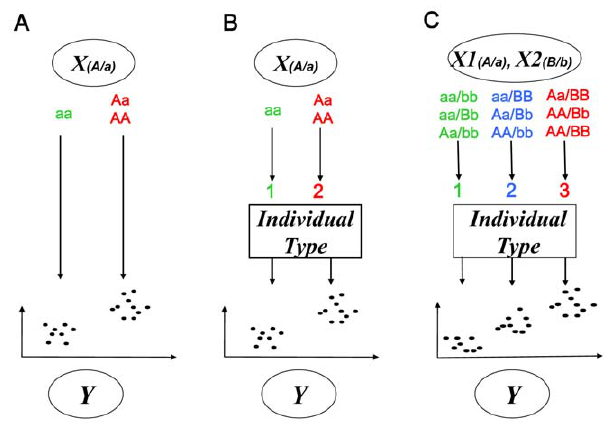
Figure 2. Comparison of different models for associating genotypes and phenotypes. (A) the regression model; (B) the Bayesian partition (BP) model with a single biallelic marker ; (C) the BP model with two interactive biallelic markers. In the regression model, gene expression values (Y) are regressed onto marker genotypes (X). If the marker has a dominant effect on the gene expression, the regression implicitly partitions the expression values into low and high groups corresponding to genotypes aa for, say, low expression and Aa or AA for high expression. In the BP model, a latent variable, denoted here as ‘‘Individual Type’’, is introduced and conditional on this variable the gene expression traits and marker genotypes are independent. In the case of a single marker, two individual types exist, colored here as green and red. In (c), gene expression is linked with a set of two biallelic markers. In this instance, individuals are partitioned into three types, colored here as green, blue and red, corresponding to low, medium, and high expression levels, respectively.